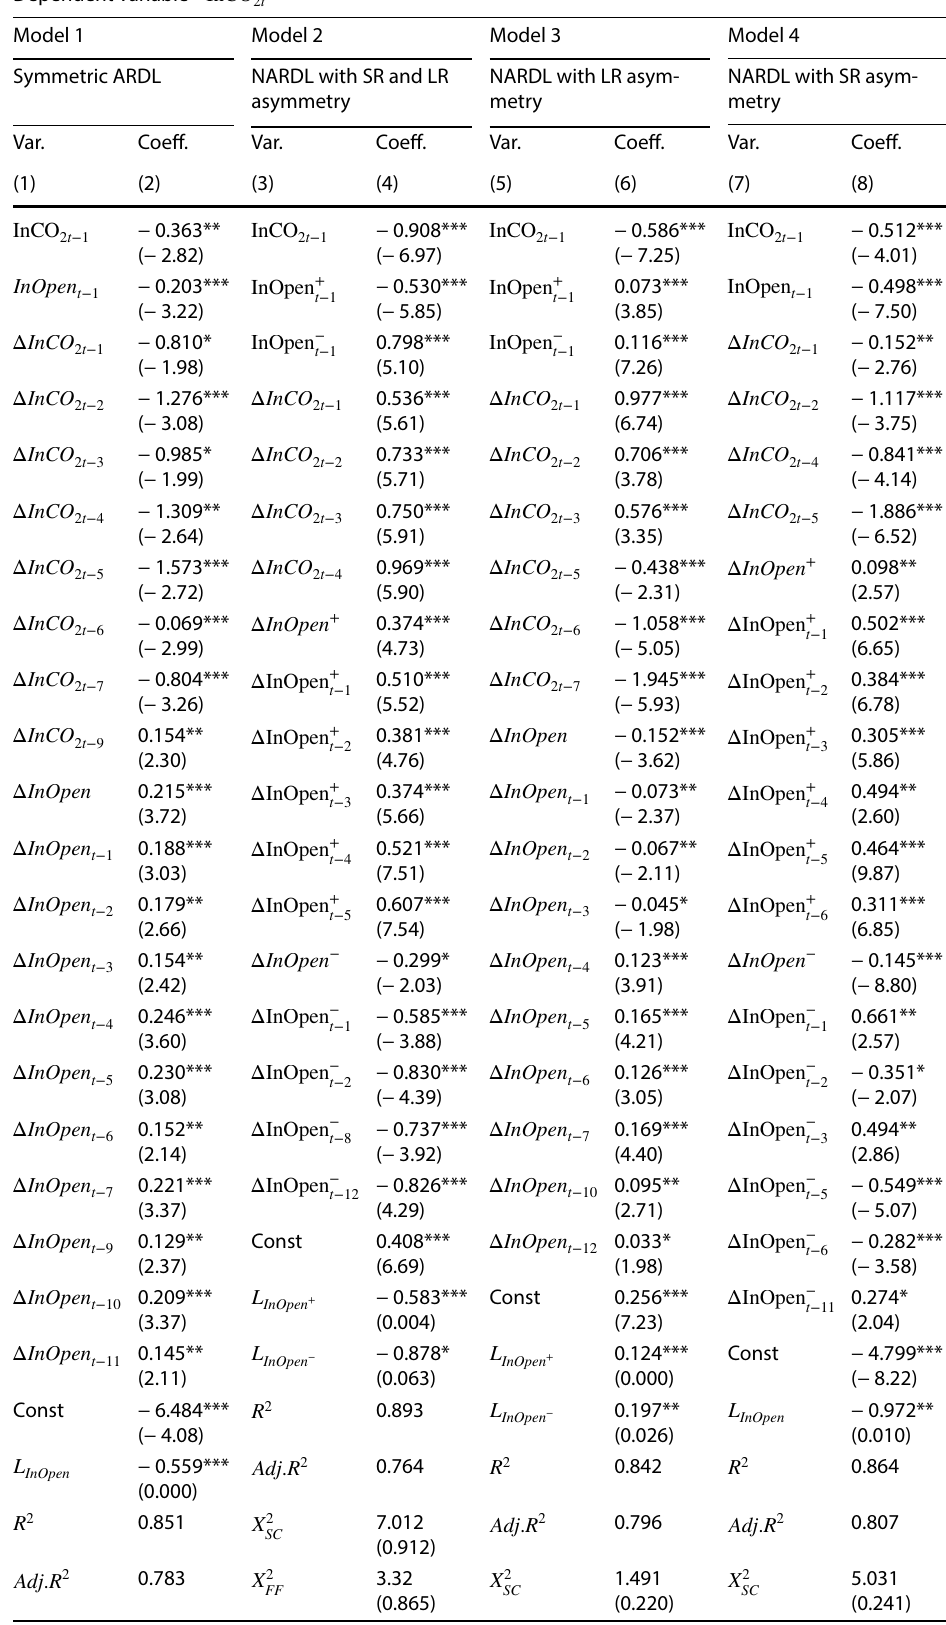
Dependent variable = InCO 2